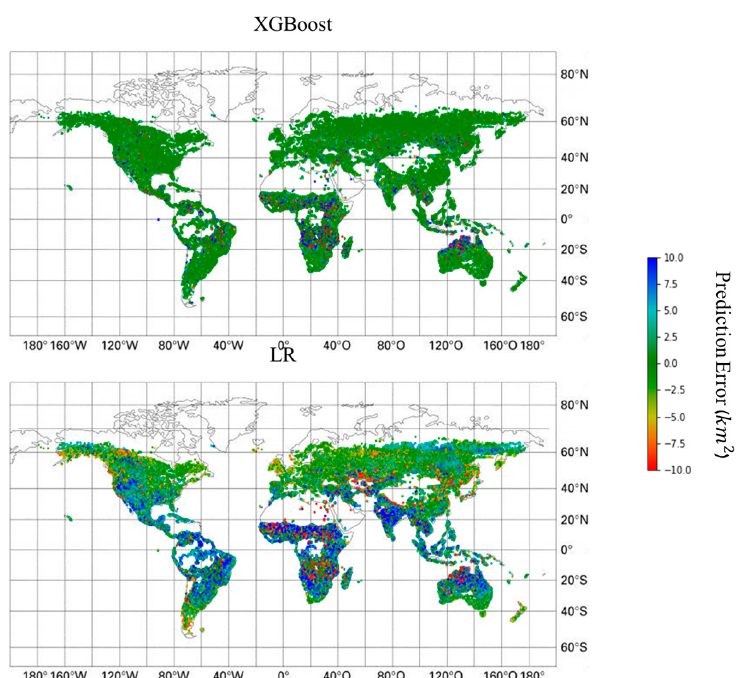
Figure A4. Similar to Figure 7, but for the models which do not include wildfire history variables.